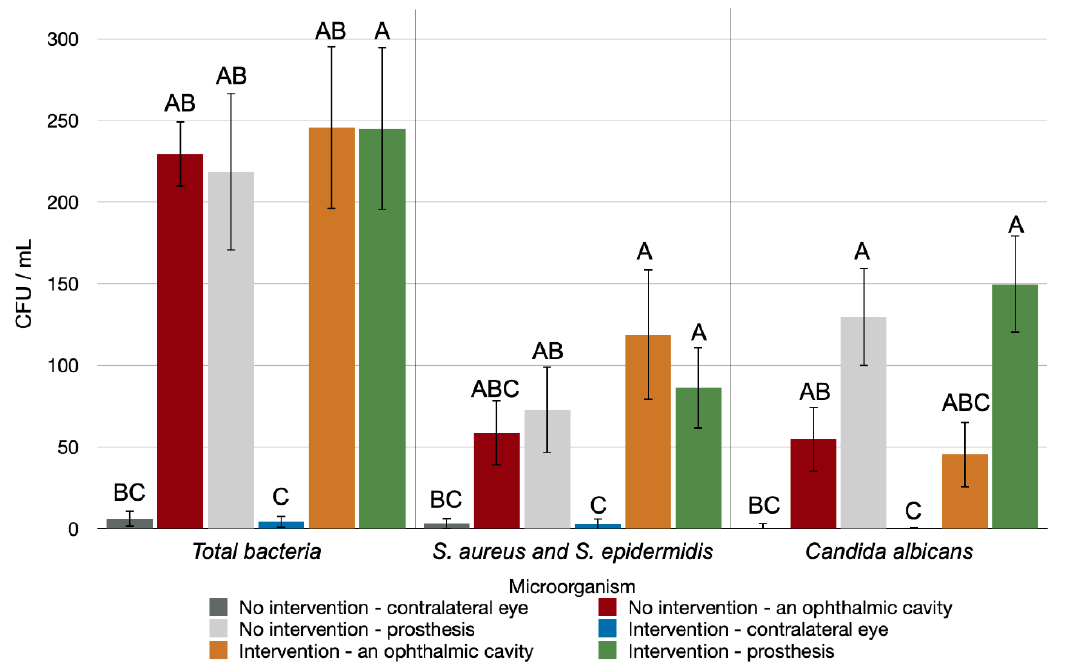
Figure 2. Number of CFUs/mL of the different types of microorganisms evaluated in the initial period in the different regions analyzed in the IG compared with the NIG. Capital letters indicate a statistically significant difference for each type of microorganism separately (Kruskal–Wallis, p <